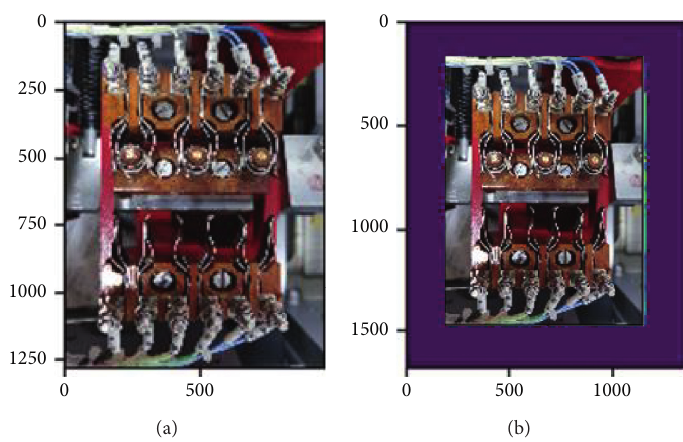
Figure 11: The pixel expansion effect: (a) the original image; (b) the image after